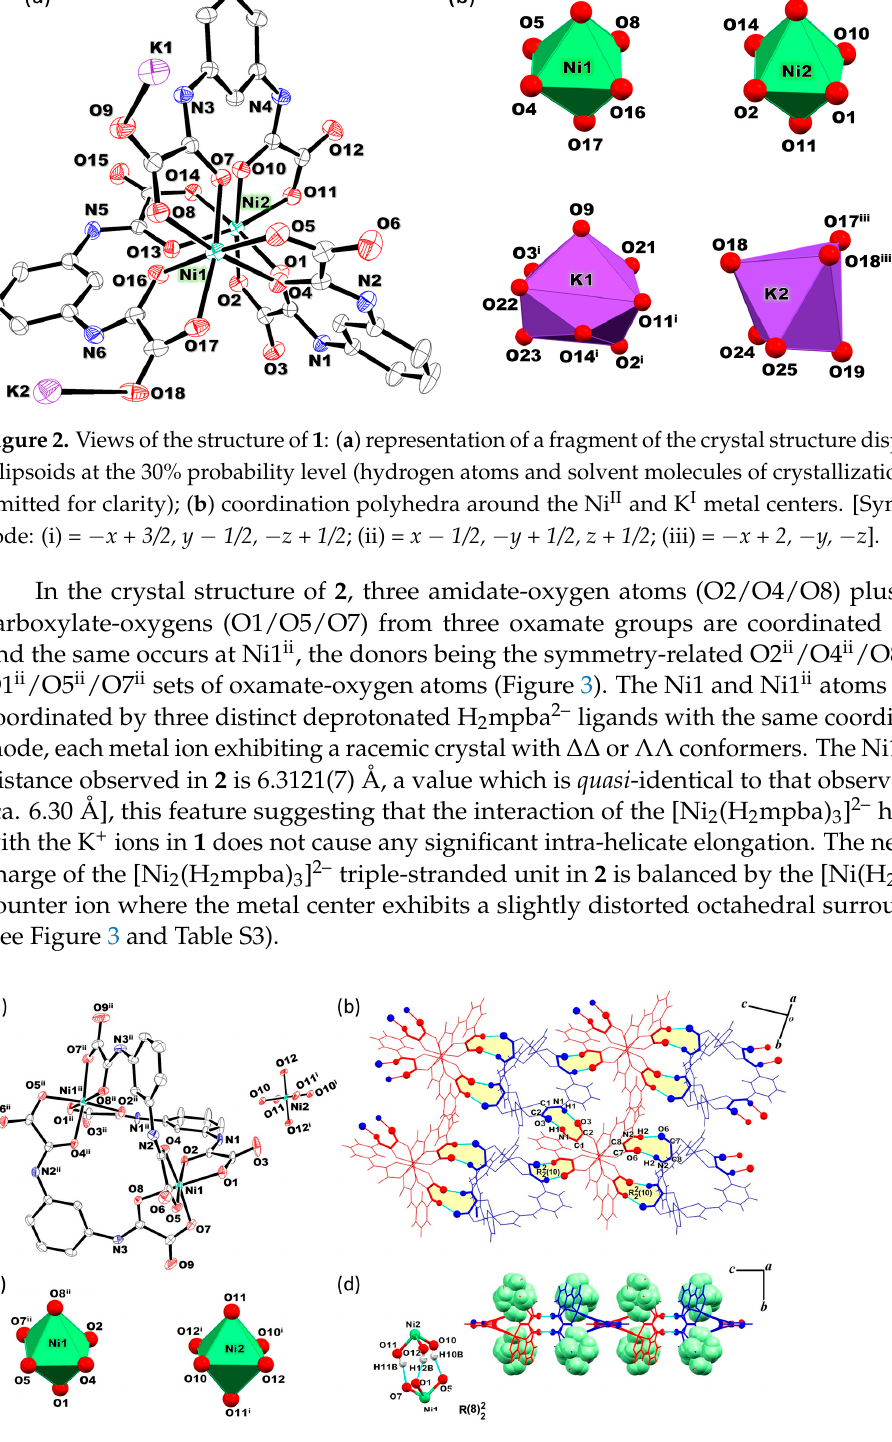
Figure 3. Crystal structure and supramolecular environment in the multi-component complex 2 : ( a ) perspective view of a fragment of the crystal structure of 2 (the hydrogen atoms were omitted for clarity and the thermal ellipsoids were drawn at the 30% probability level); ( b ) supramolecular 2D expansion built from homosynthons expanding along the crystallographic bc plane (each helicate entity interacts with three neighboring ones through four homosynthons); ( c ) polyhedral representation of the two crystallographically-independent Ni II ions; ( d ) 3D supramolecular expansion reached via the [Ni(H 2 O) 6 ] 2+ unit as hydrogen bond donor [Symmetry code: (i) = − x, − y, − z ; (ii) = − x + 5/4, − y + 1/4, z ; (iii) = − x + 7/4, y, − z + 7/4 ; (iv) = x, − y + 1/4, − z + 9/4 ].